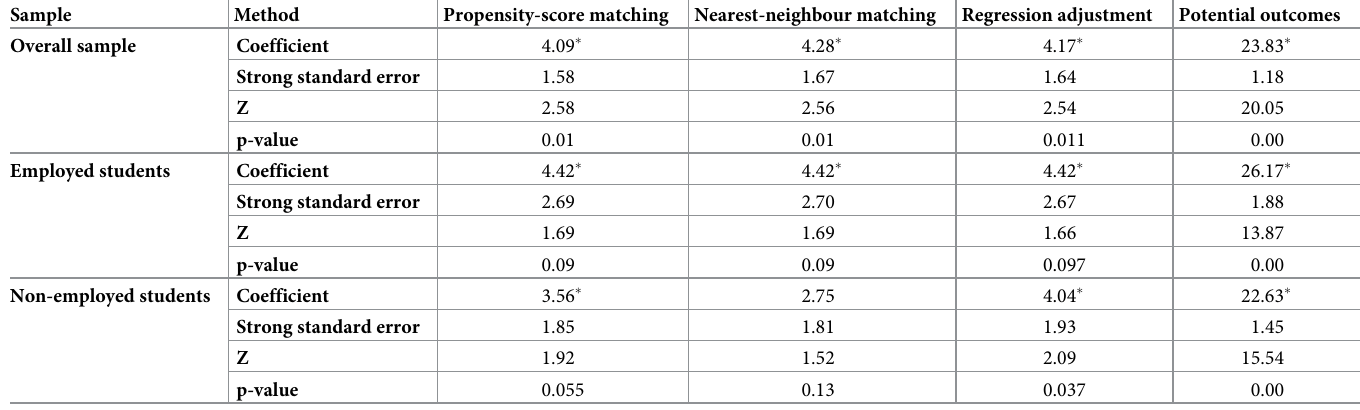
Table 3. The estimated results of treatment (coping strategies) effects in order to assess the impact of status on labour market regarding stress scores (control vari- ables: Gender, marital status, age